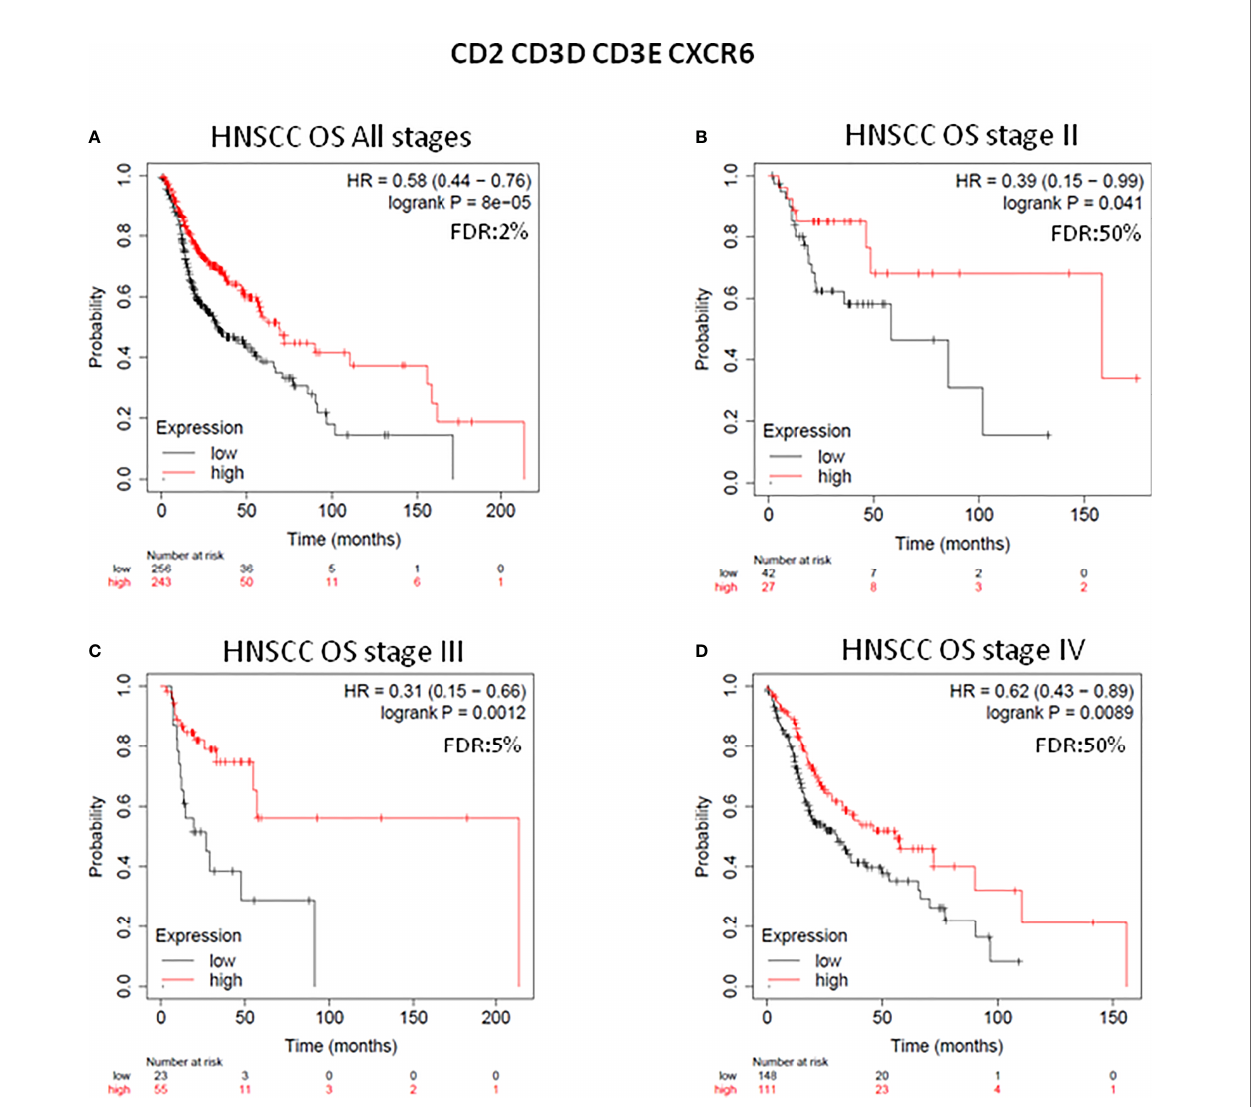
FIGURE 2 | Clinical outcome analysis of CD2 , CD3D , CD3E , CXCR6 immune gene-set combination in each stage of HNSCC patients. Survival plots of the combination of four immune genes with the most favorable prognosis (HR < 0.65, p value < 0.05, and FDR < 10%) at all stages of HNSC patients (n = 527) (A) , at stage II (n = 69) (B) , at stage III (n = 78) (C) , and at stage IV (n = 259) (D) are displayed. Patients whose tumors harbor high gene expression levels predicted better survival (red line), and those with low gene expression levels predicted worse survival (black line). Number of patients at risk at every time (months), with high (in red) and low gene expression (in black) are displayed. HR for risk of death and OS are displayed. HR < 0.65 discriminates a risk reduction. FDR is also displayed. The gene combination is displayed at the top of the fi